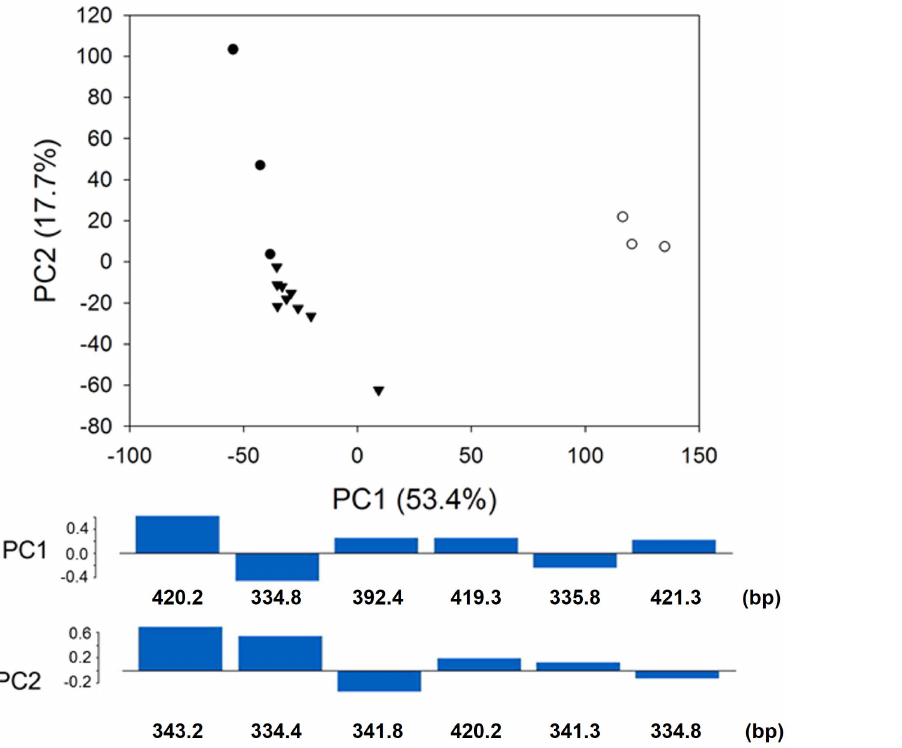
Figure 3. PCA results extracted from LH profiles of 15 fecal samples from collected from different regions in between 2011 and 2012. Bars represented loading values of the first principal component (PC1) and the second principal component (PC2). Open circles: Love´nbreen, Ny-A˚lesund in 2011; Closed circles: Brøggerbreen, Ny-A˚lesund in 2012; Closed inverted triangles: Love´nbreen, Ny-A˚lesund in 2012.